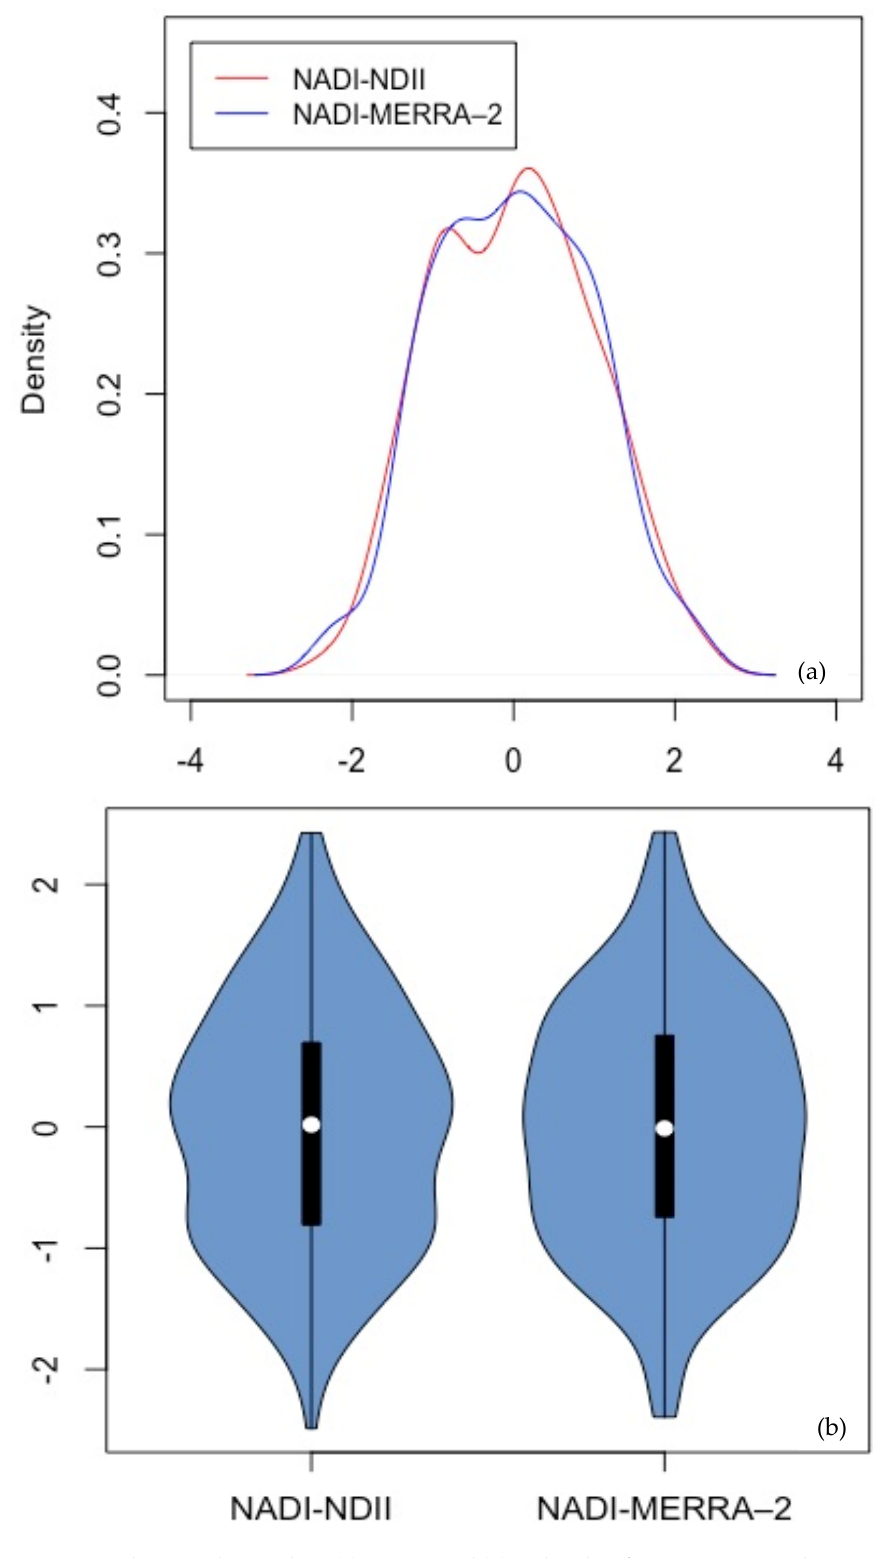
Figure 3. Exploratory data analysis ( a ) Density and ( b ) violin plots for NADI-NDII and NADI-MERRA–2.